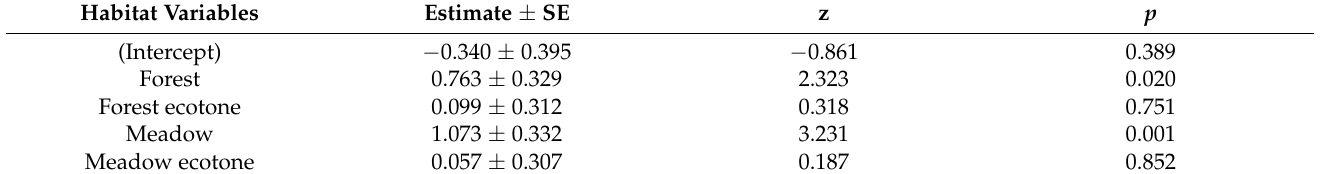
Table 3. A linear mixed model with Heracleum PC as the dependent variable and habitat category as a nominal predictor. “Count ID” was the random effect.